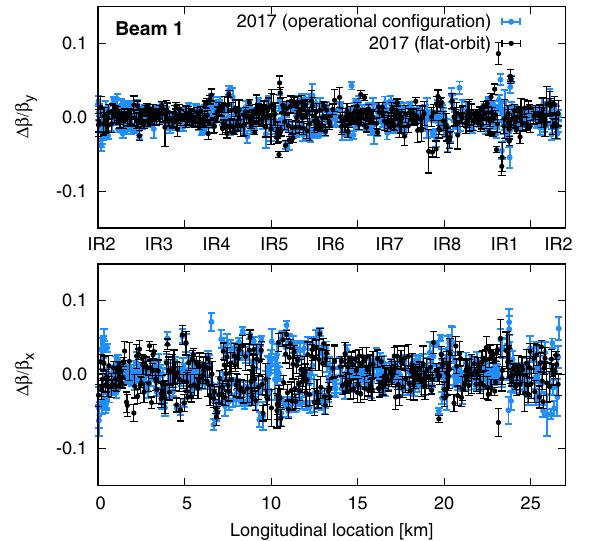
FIG. 28. β -beat in Beam 1 measured for flat orbit and the operational configuration at β (cid:1) ¼ 0 . 4 m in 2017.